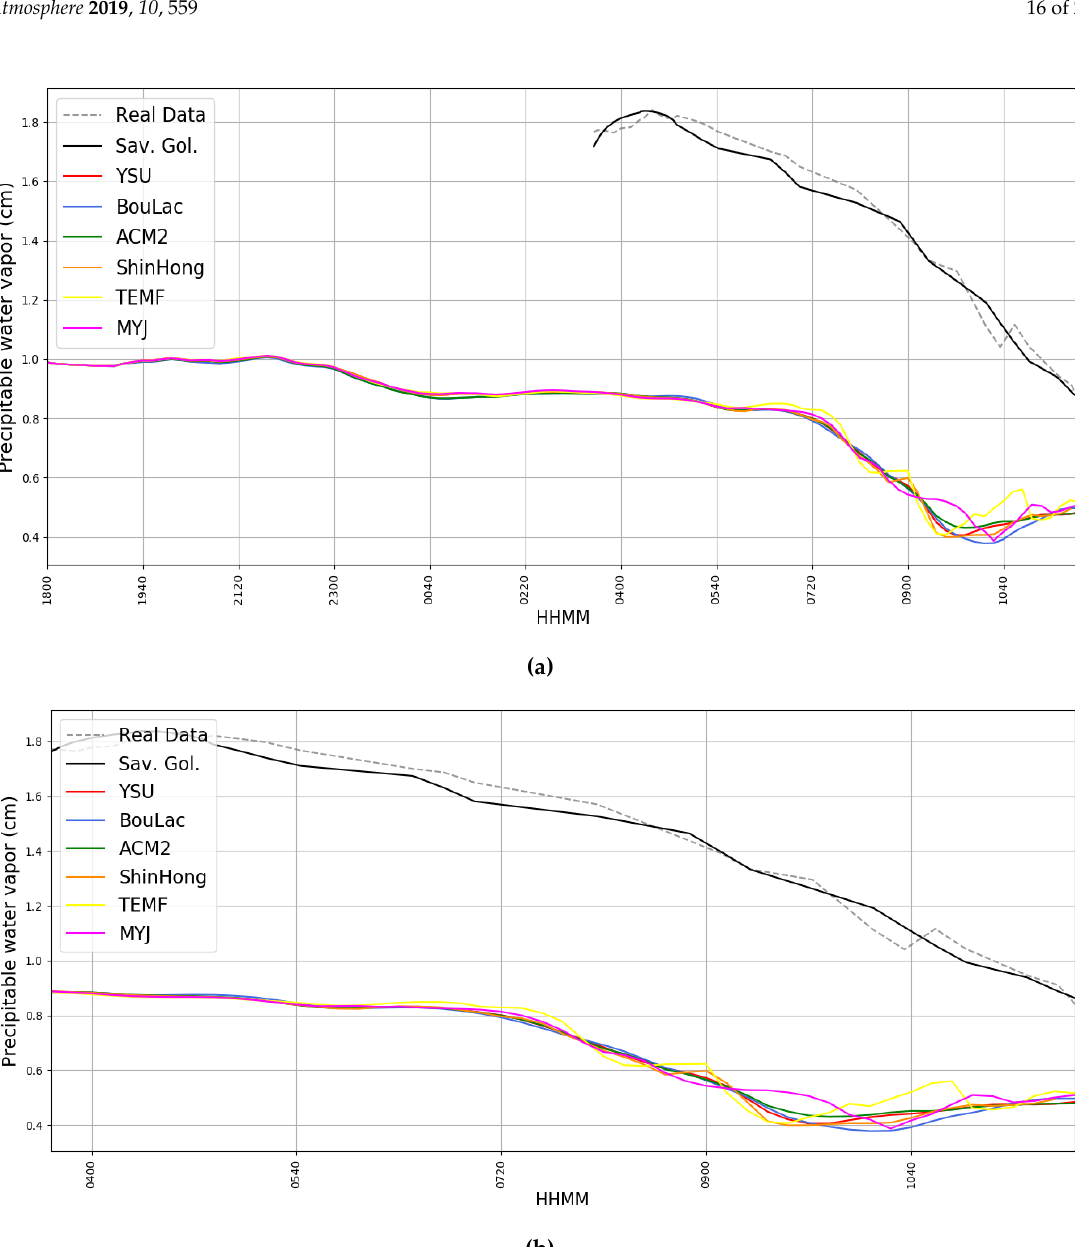
Figure 16. ( a ) Simulated WV timeseries compared with photometer-retrieved WV timeseries, 17 / 05 / 2017, dotted grey: real data, black: Savitsky–Golay smoothing of real data, red: simulated data with YSU parametrization, blue: simulated data with BouLac parametrization, green: simulated data with ACM2 parametrization, orange: simulated data with ShinHong parametrization, yellow: simulated data with TEMF parametrization, purple: simulated data with MYJ parametrization. ( b ) Simulated WV timeseries compared with photometer-retrieved WV timeseries, zoomed-in, 17 / 05 / 2017, dotted grey: real data, black: Savitsky–Golay smoothing of real data, red: simulated data with YSU parametrization, blue: simulated data with BouLac parametrization, green: simulated data with ACM2 parametrization, orange: simulated data with ShinHong parametrization, yellow: simulated data with TEMF parametrization, purple: simulated data with MYJ parametrization .